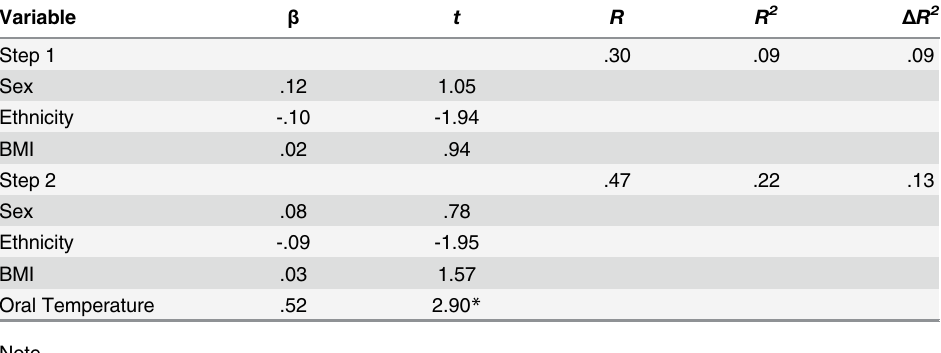
Table 1. Summary of Hierarchical Regression Analysis for Variables Predicting Oral Temperature.